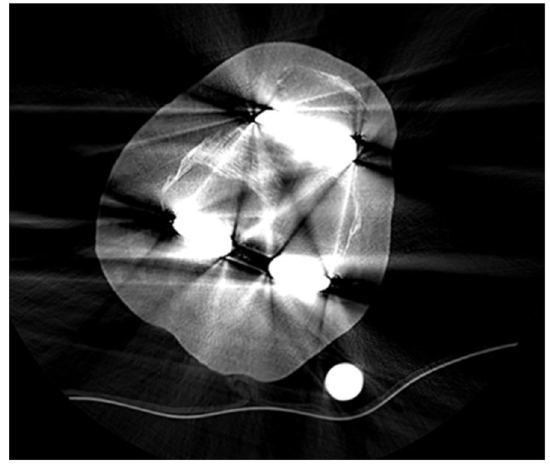
Fig. 1 CT slice of a femoral component without metal artefact reduction software (MARS)